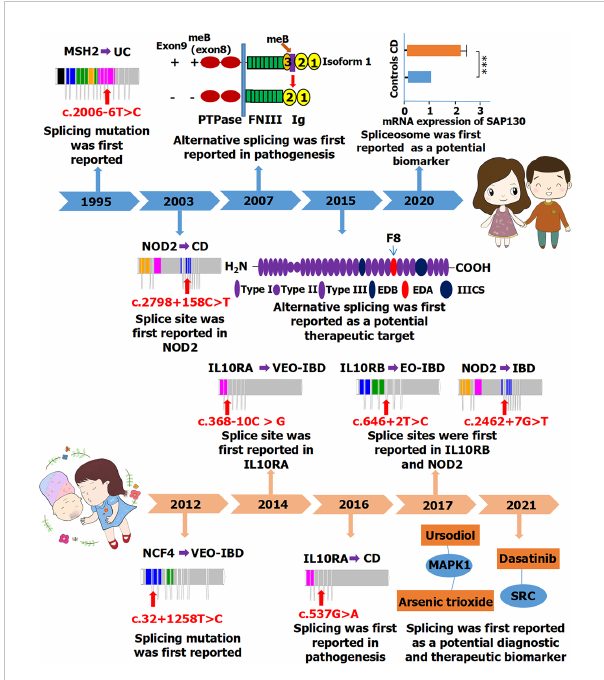
FIGURE 4 A timeline of alternative splicing and splicing mutations reported in IBD (including CD and UC) between adults (Top) and children (Bottom). PTPase, protein-tyrosine phosphatase; FNIII, fi bronectin type III; SAP130, spliceosome-associated protein 130; *** P < 0.001; IIICS, type III connecting segment; MAPK1, mitogen-activated protein kinase 1; SRC, proto-oncogene tyrosine-protein kinase Src. The full names of those genes are shown in Table